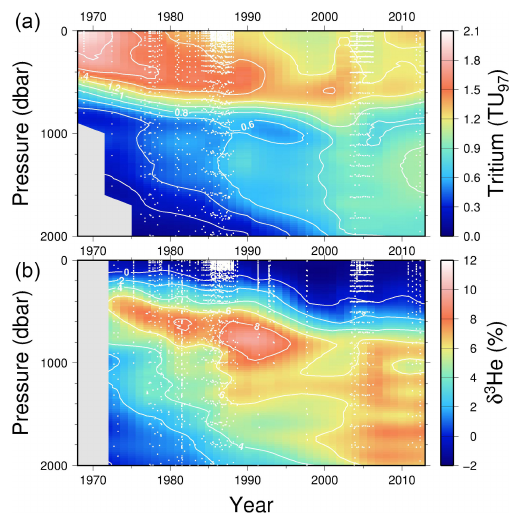
Figure 7. A time series of tritium (upper) and helium isotope mea- surements in the vicinity of Bermuda (North Atlantic). Tritium val- ues have been decay-corrected to a common time (1 January 1997). White dots indicate sampling depths and